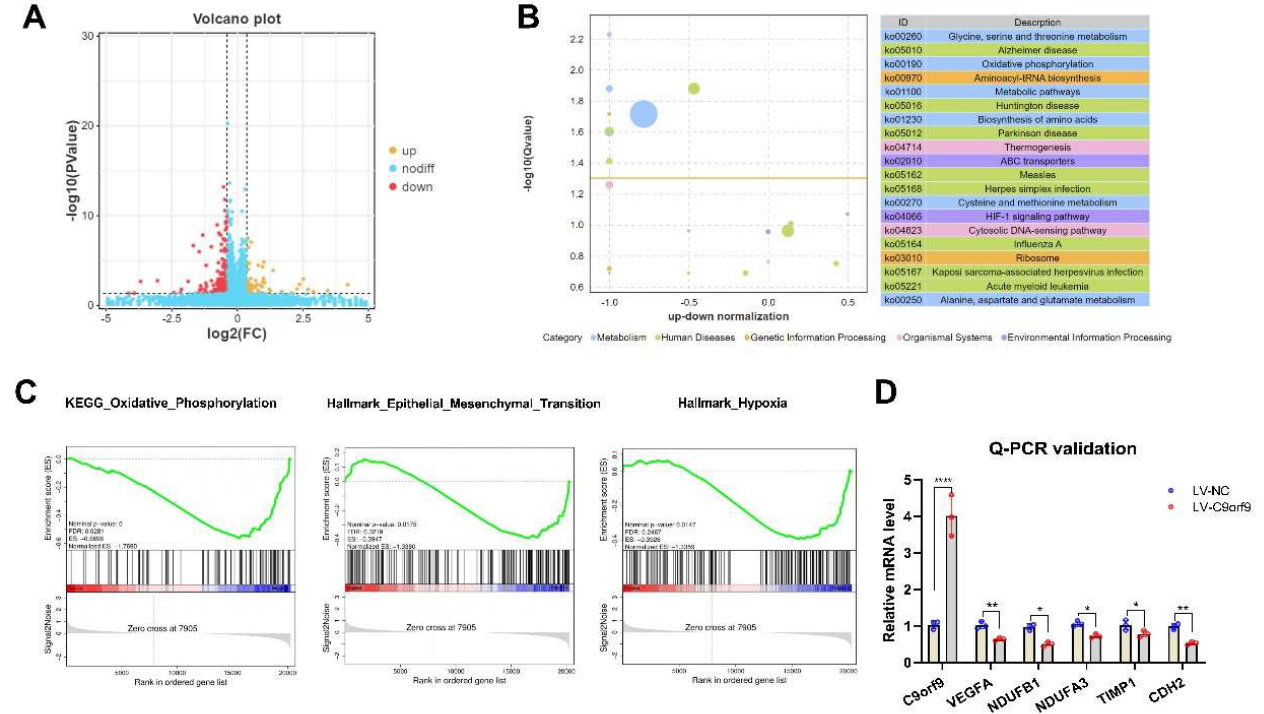
Figure 7. C9orf9 regulates metastasis-related gene and pathway. ( A ). Volcano plot of differentially expressed genes (DEGs). ( B ). Top 20 KEGG pathway enrichment from DEGs. ( C ). GSEA plot of oxidative phosphorylation, EMT, and hypoxia gene set. ( D ). Q-PCR validation of angiogenesis, oxidative phosphorylation, and EMT related genes. * p < 0.05, ** p < 0.01, **** p < 0.0001.